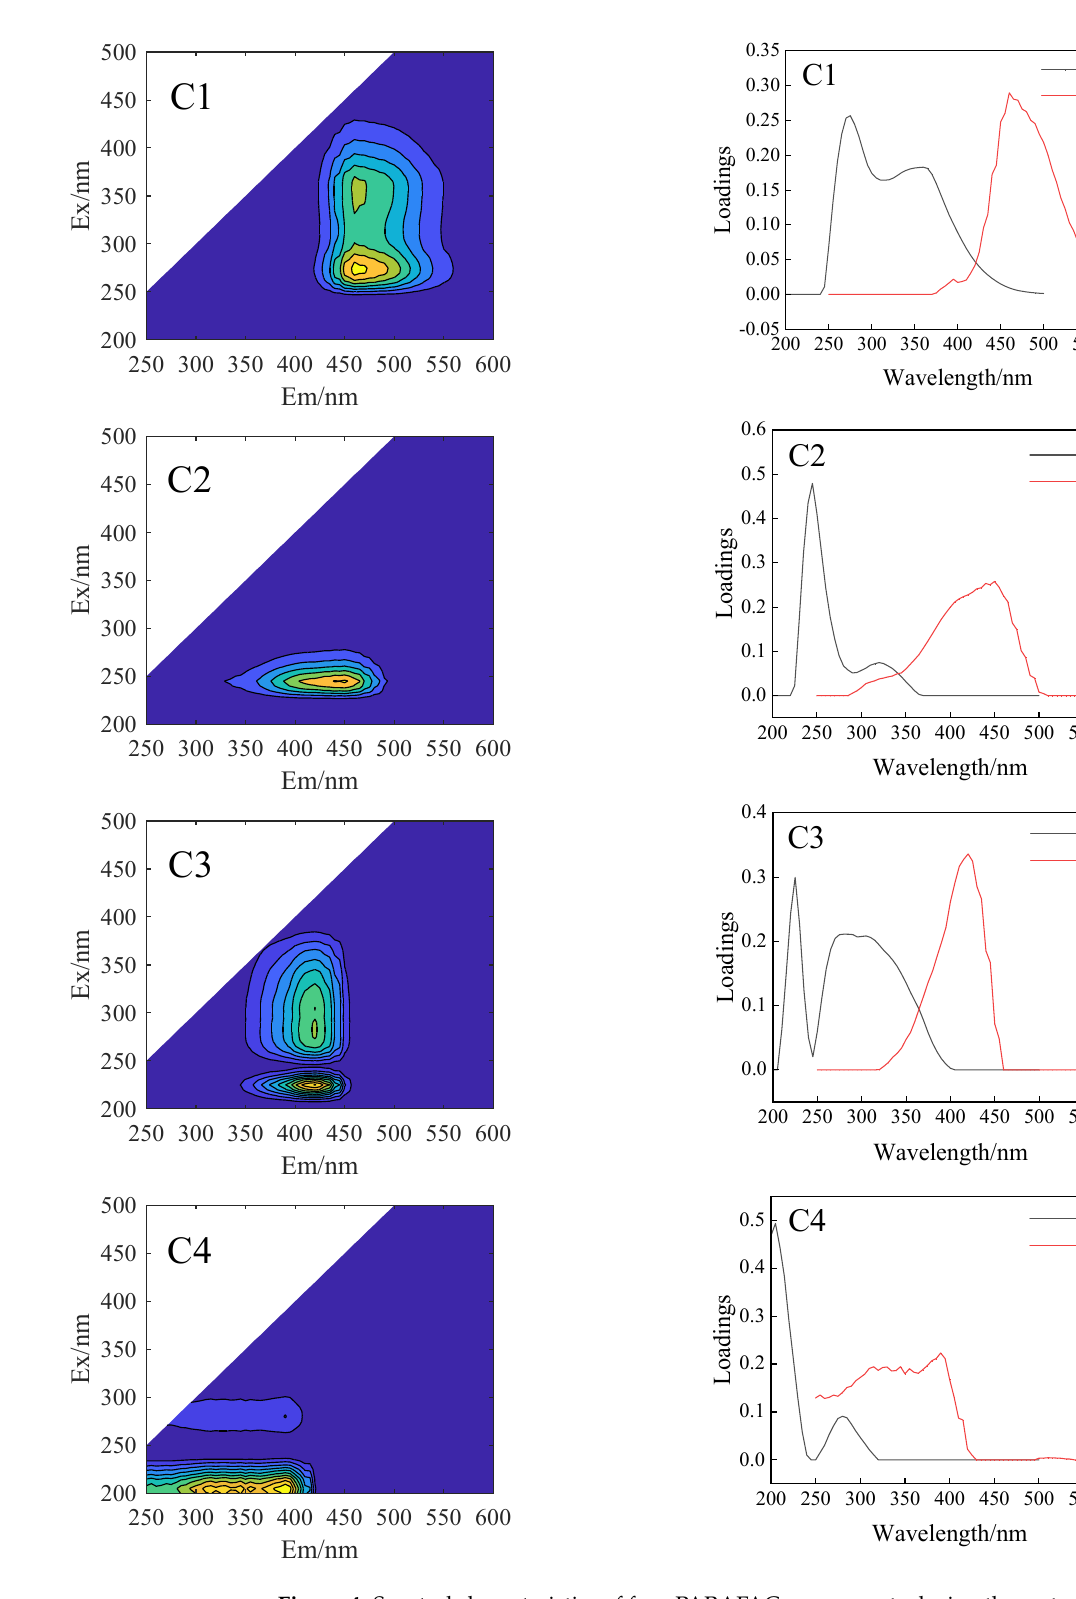
Figure 4. Spectral characteristics of four PARAFAC components during the wet season. Two lines in the excitation and emission (right panels) show the results of split-half